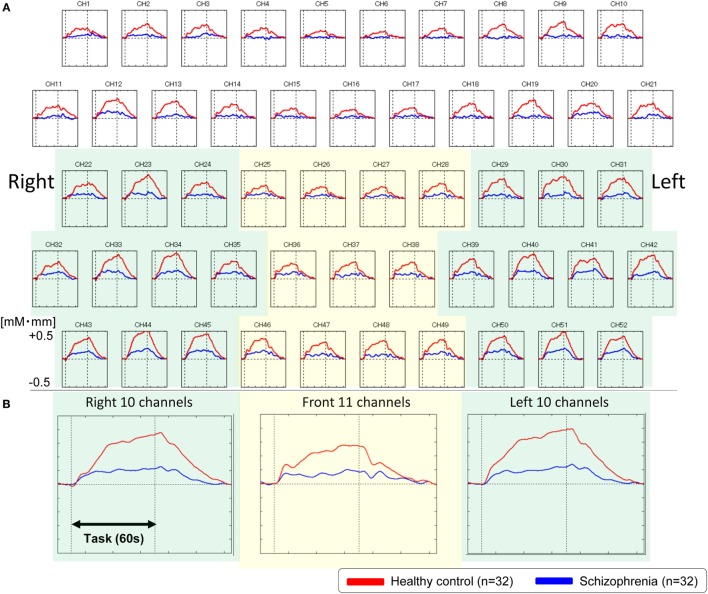
Waveforms of oxygenated-hemoglobin (oxy-Hb) concentration changes during the VFT. (A) The upper figures show the overall average waveforms of concentrations of oxy-Hb changes during the VFT in patients with schizophrenia (blue) and healthy controls (red). (B) In the lower three figures, the right figure shows the average waveforms of oxy-Hb changes for the 10 channels in the right VLPFC/aTC region, the center figure shows the average waveforms of oxy-Hb changes for the 11 channels in the frontal pole region, and the left figure shows the average waveforms of oxy-Hb changes for the 10 channels in the left VLPFC/aTC region. Abbreviations: VLPFC, ventrolateral prefrontal cortex; aTC, anterior part of the temporal cortex; VFT, verbal fluency task.